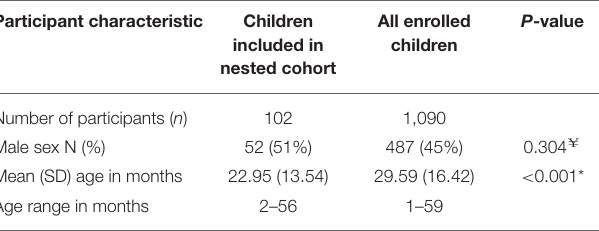
TABLE 1 | Baseline demographics of participants whose samples were included in the nested cohort study of 16S rRNA sequencing vs. all participants who provided fecal samples for the cross sectional survey of antimicrobial resistance.